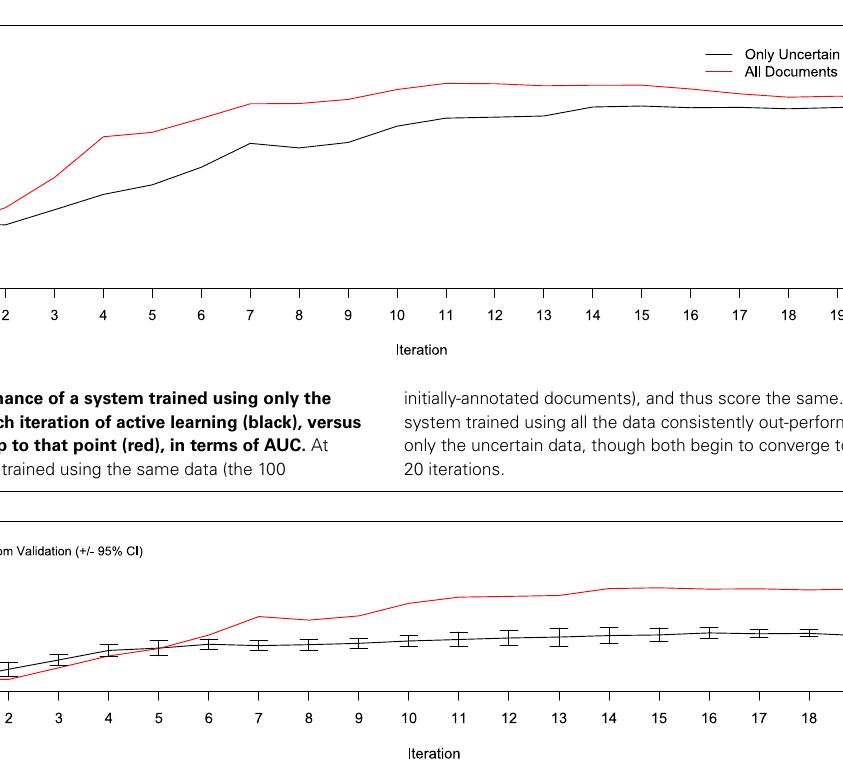
samplings, so that standard error could be calculated (bars). After six iteration, the Virk system outperform the 95% confidence interval for the random validation system.